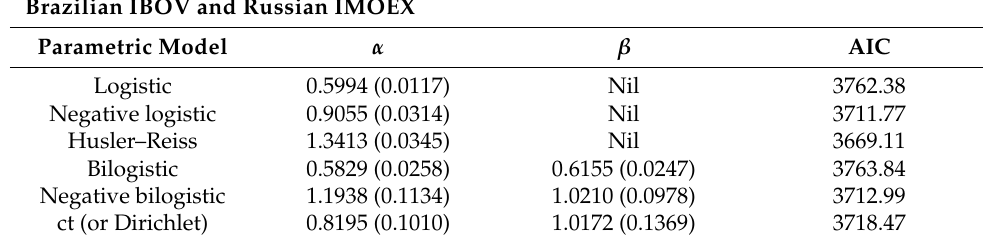
Table 5. Estimates of the point process dependence